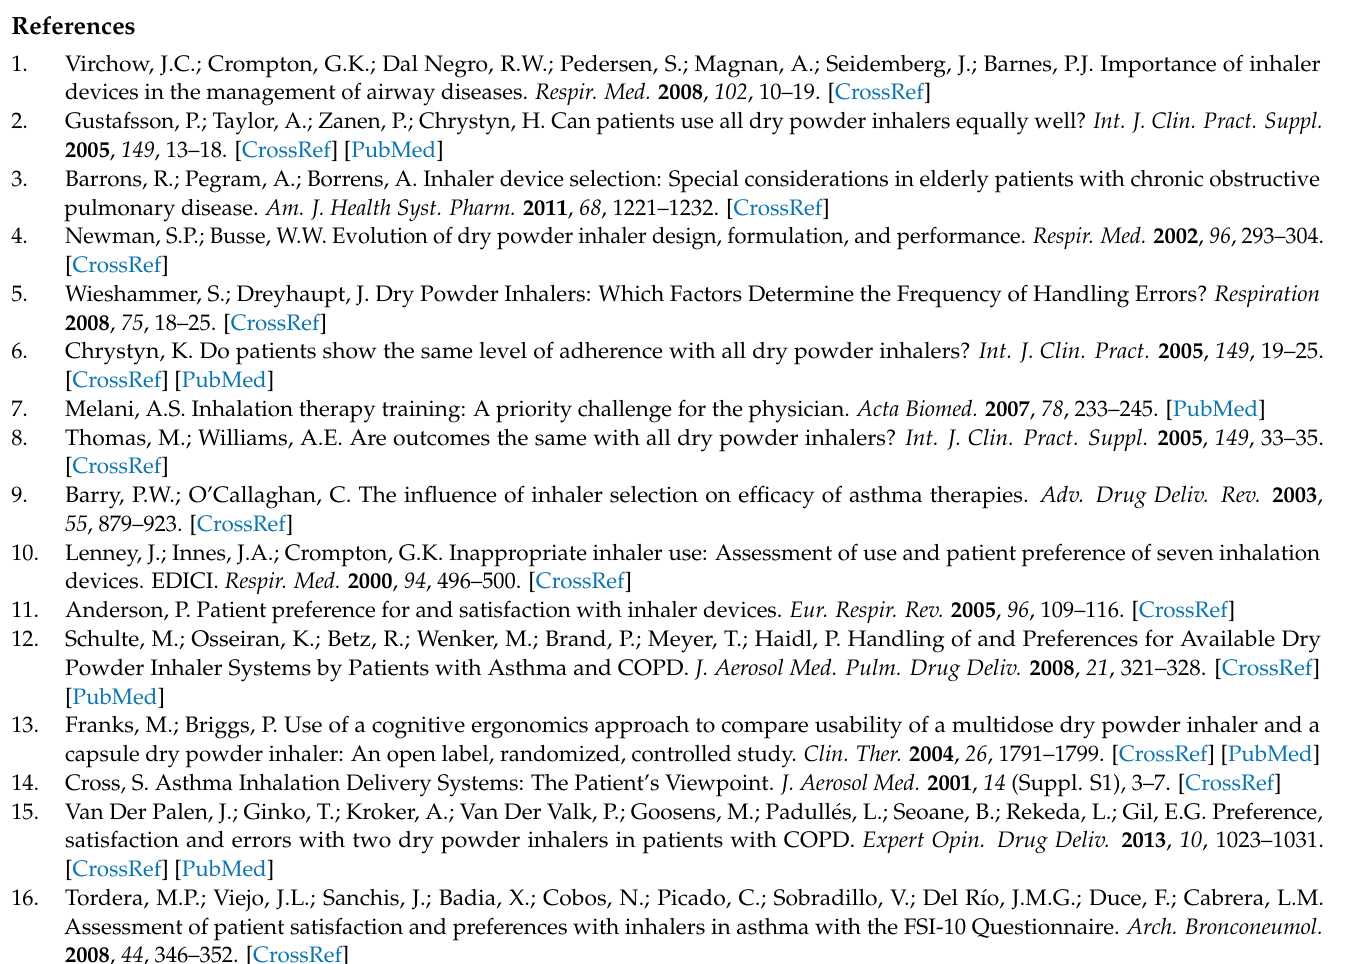
Figure A1. GUS short-form questionnaire (the score for each question in bold). *+2.5 points for each device not perceived as the most difficult to use.